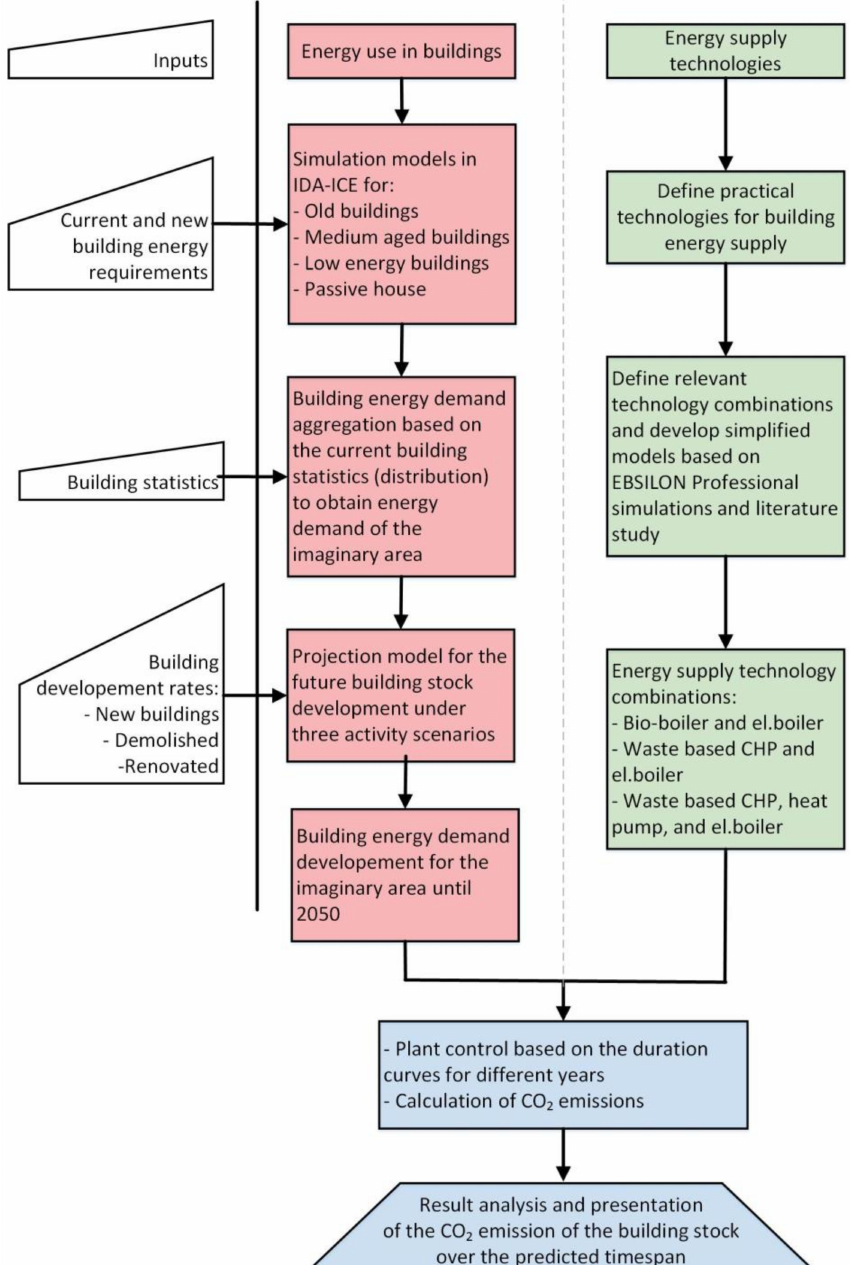
Figure 2. Main information flow for the methodology combining building energy use and energy supply. CHP, combined heat and